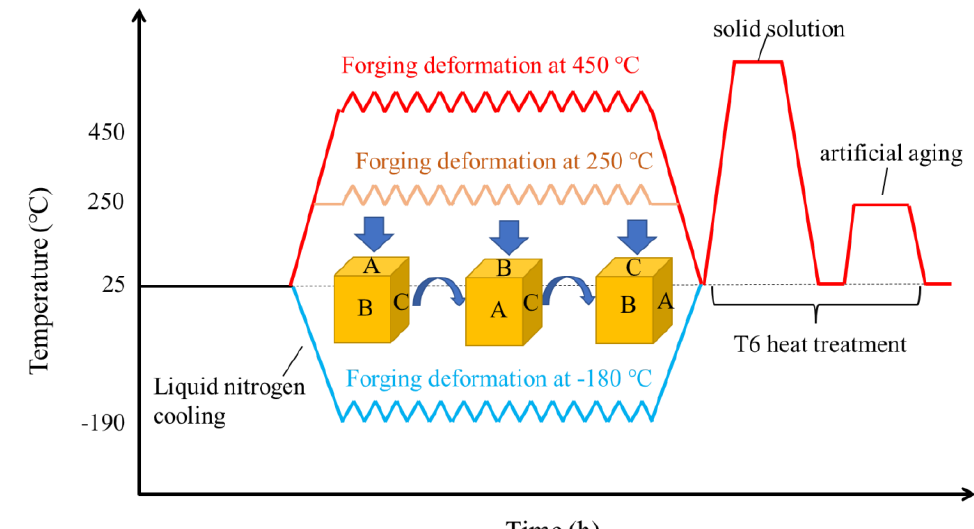
Figure 1. Schematic image of the thermomechanical processing procedures.